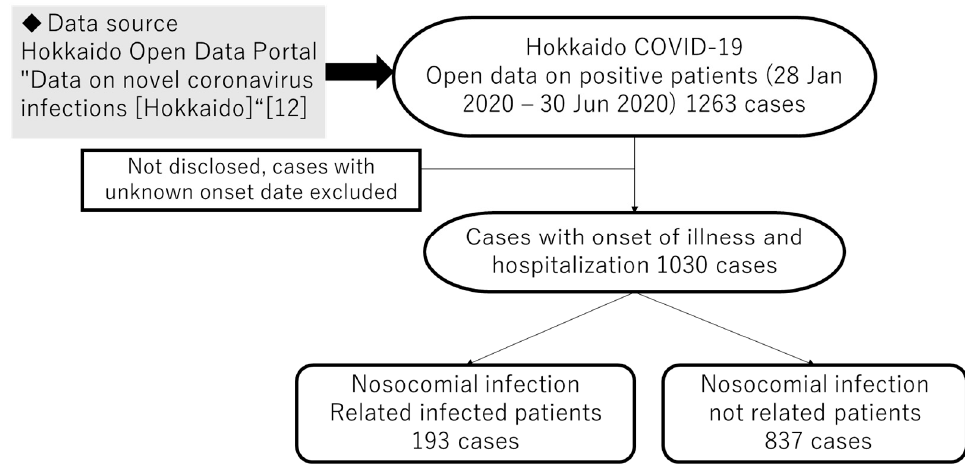
Figure 5. Flow chart from onset of illness to positive result.